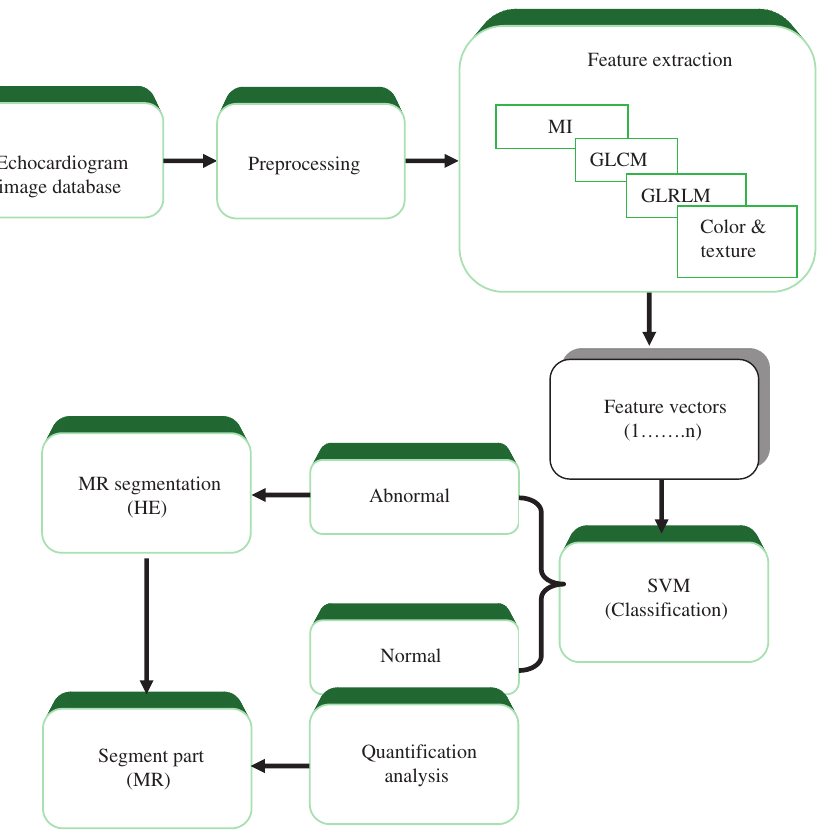
Figure 1: Block Diagram for the Proposed